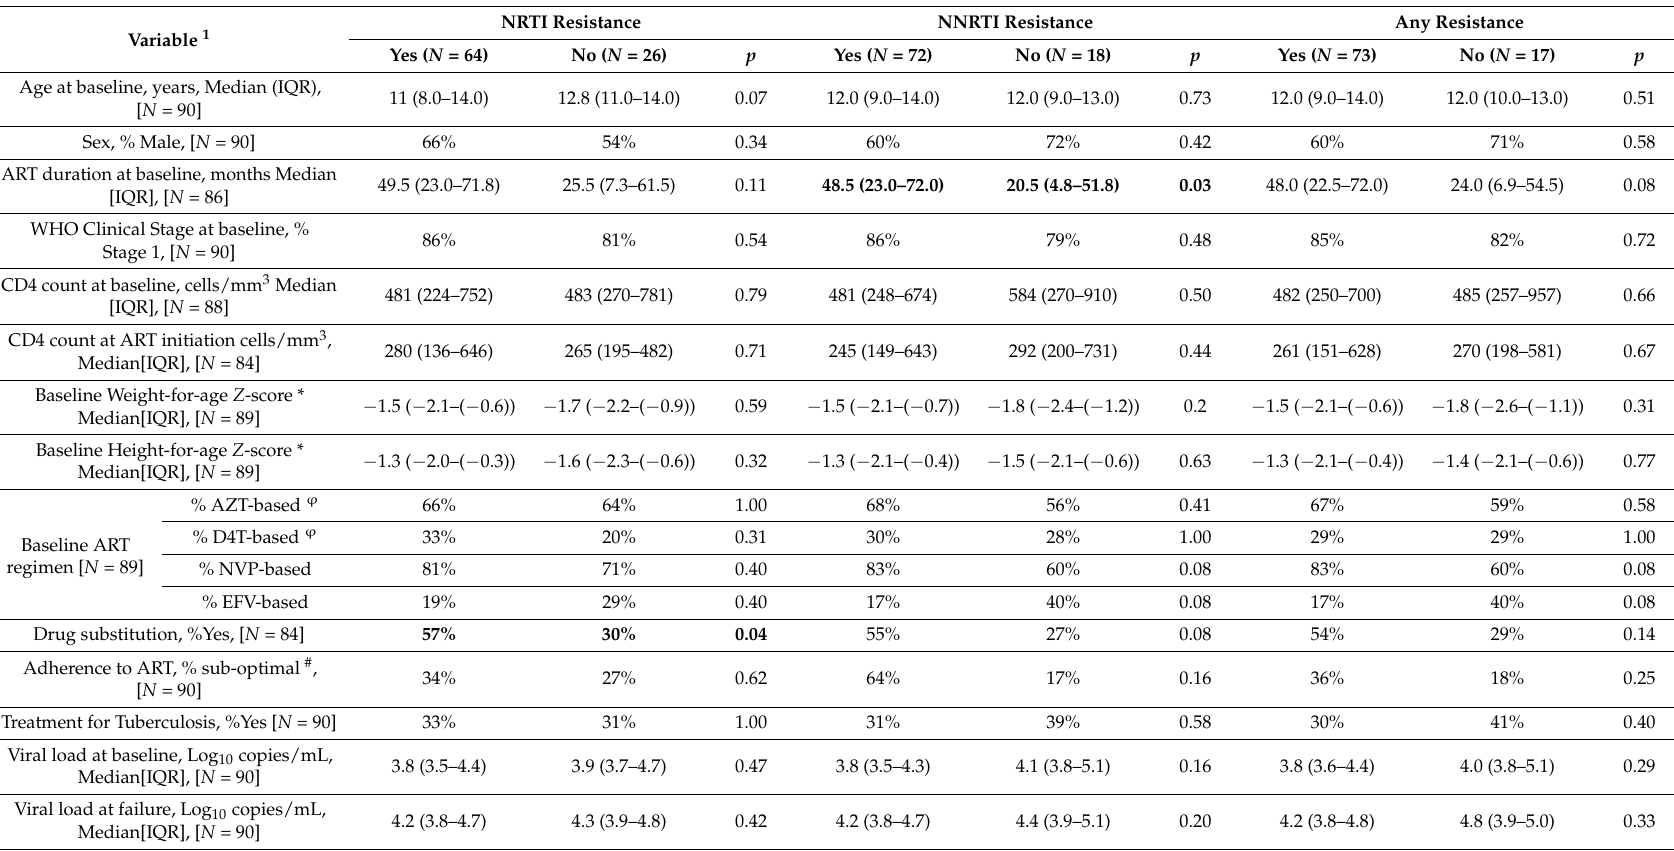
Table 2. Factors associated with HIV-1 drug resistance in Ethiopian children experiencing virologic failure of first-line cART. NRTI Resistance NNRTI Resistance Any Variable 1